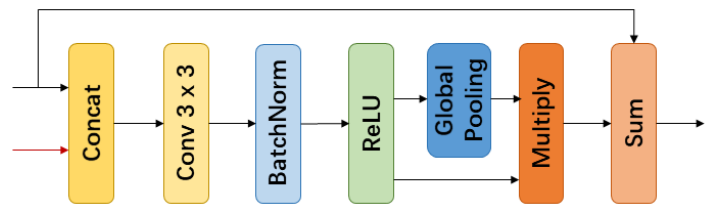
Figure 3. Attention Mix Module structure. Red line represents bilinear upsample